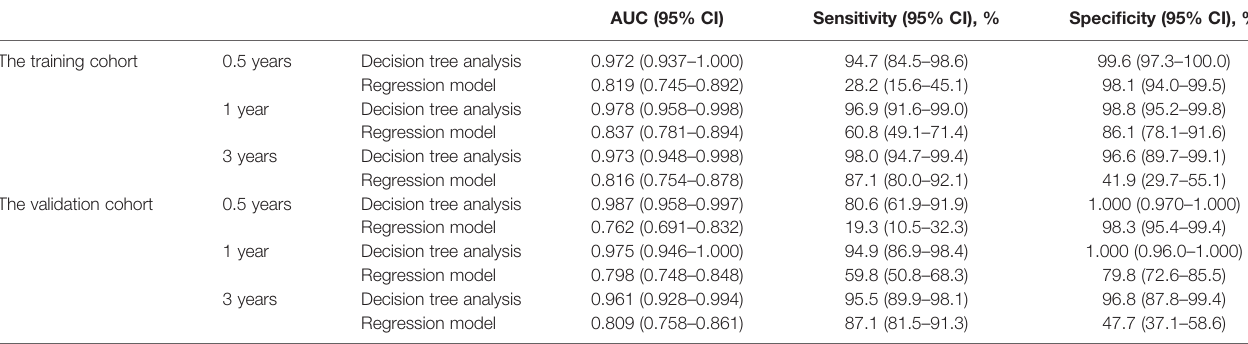
TABLE 3 | Performance indexes of decision tree analyses and regression models in the training group and testing